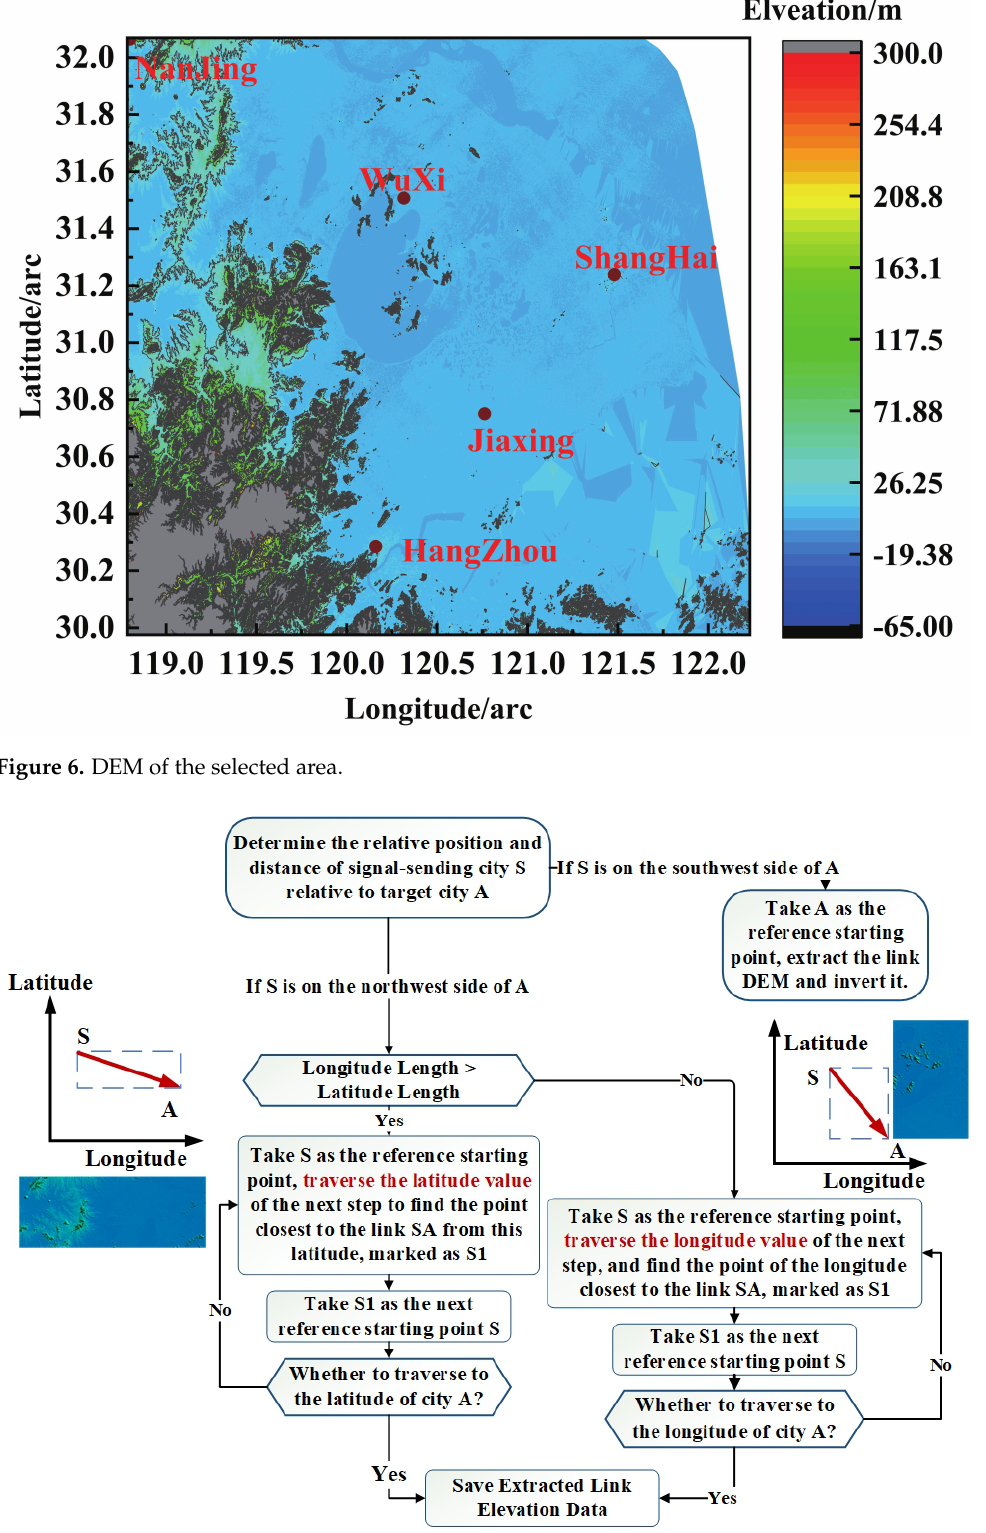
Figure 7. Flow chart of the extracting line-distributed DEM data from polygon-distributed DEM